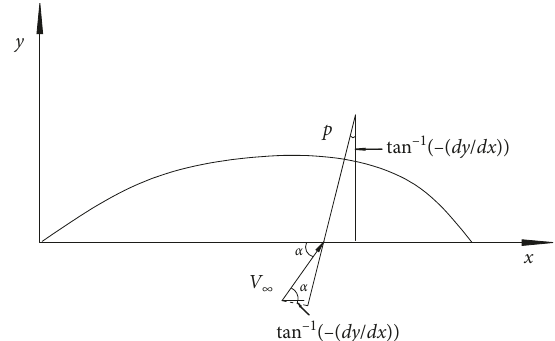
Figure 1: Normal velocity of the free stream in the middle curve.